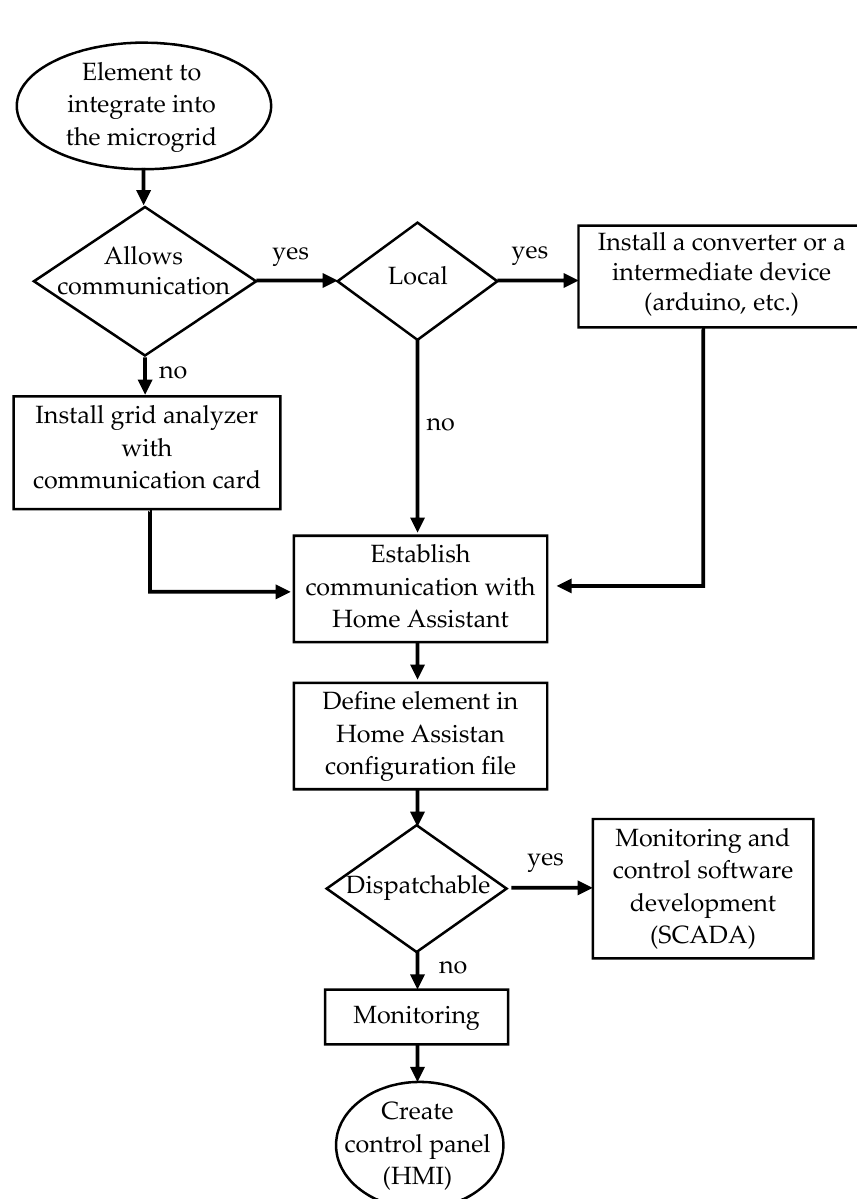
Figure 2 . Stages of the procedure to set up communication with each element of the grid. Source: prepared by authors.